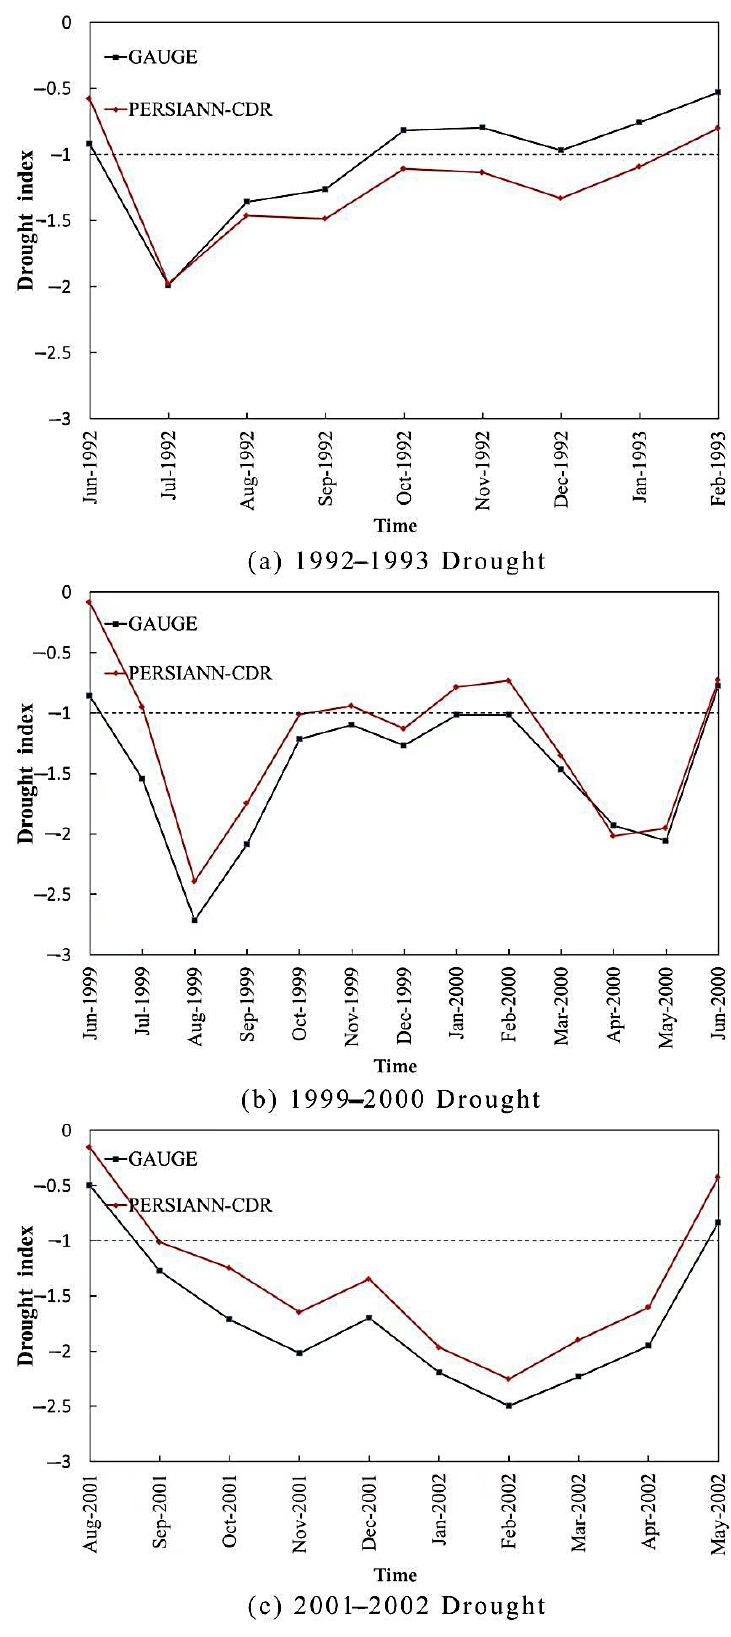
Figure 12. Time series of SPI-12 for three typical drought events: ( a ) 1992–1993 drought, ( b ) 1999–2000 drought, and ( c ) 2001–2002 drought.